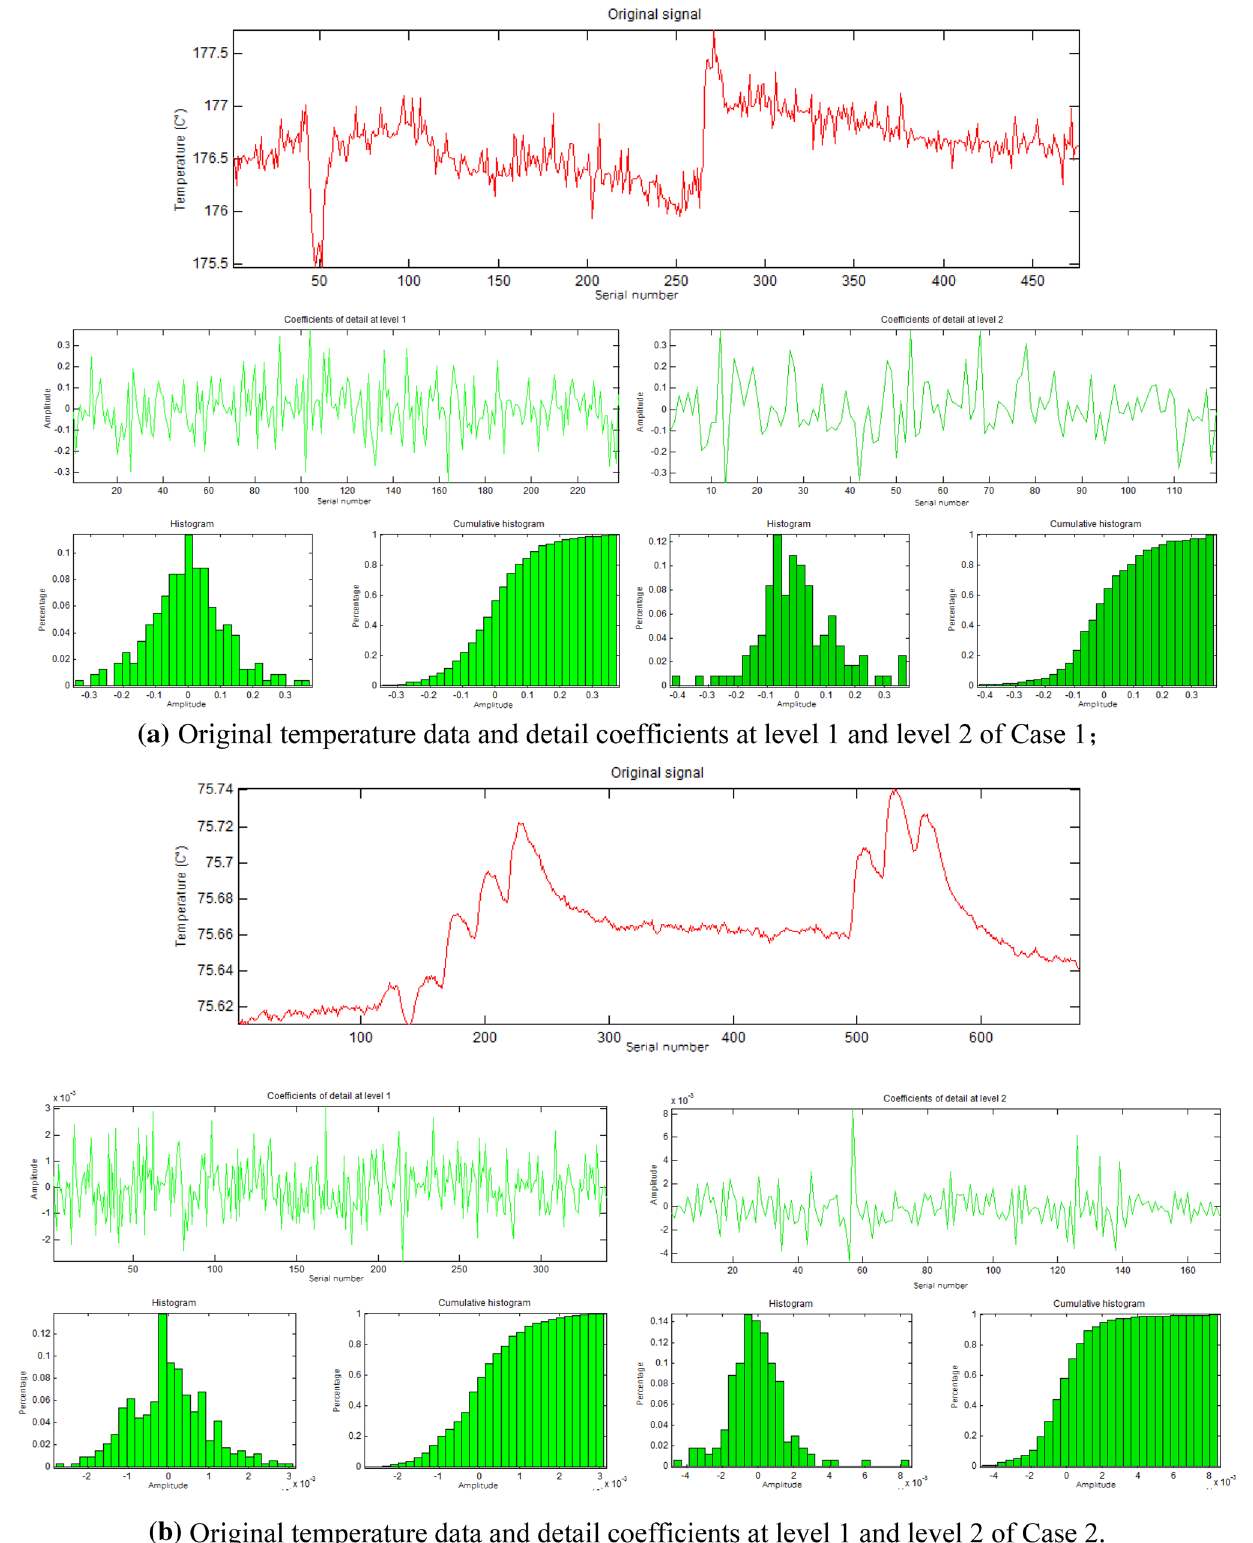
Fig. 4 PDG temperature data of Cases 1 and 2. a Original temperature data and detail coefficients at level 1 and level 2 of Case 1; b original temperature data and detail coefficients at level 1 and level 2 of Case